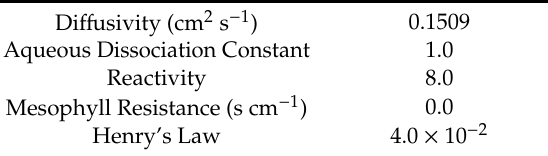
Table 1. Chemical properties of benzene specified in the California pu ff (CALPUFF)